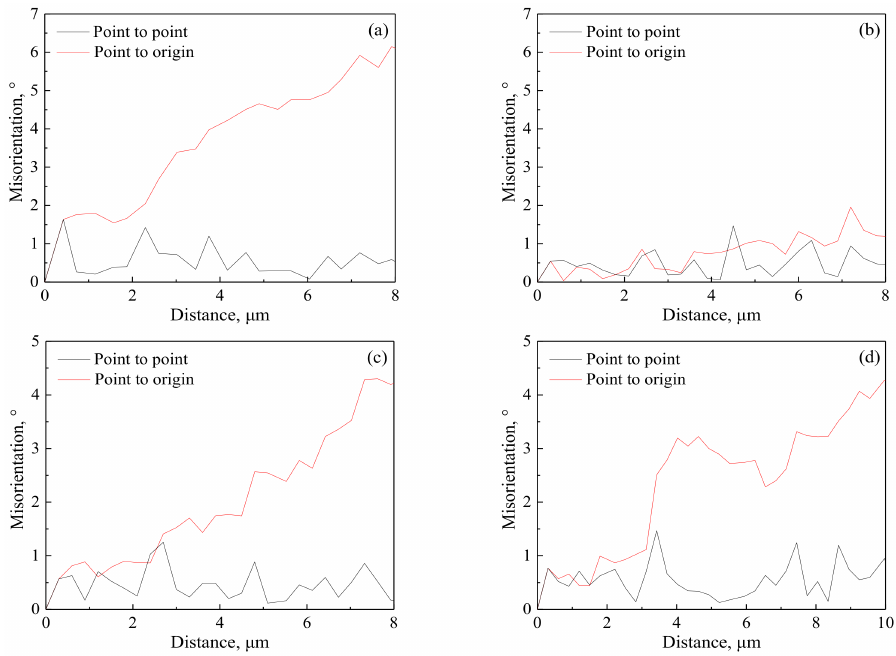
Figure 8. Misorientation angle changes near the original high-angle grain boundaries along the arrows in Figure 7b,c: ( a ) A1, ( b ) A2, ( c ) B1 and ( d )